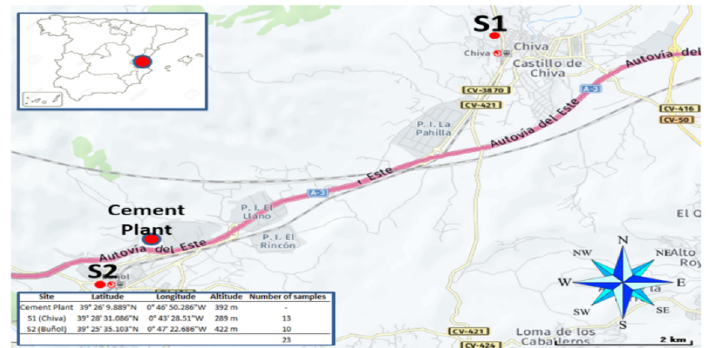
Figure 1. Location of the evaluated stations (S1 and S2) and cement plant.